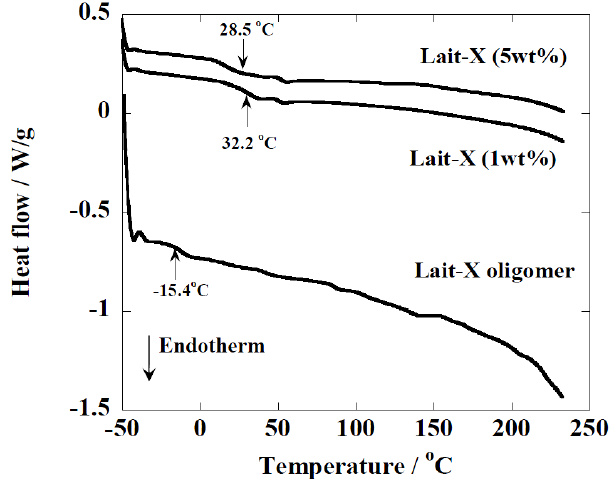
Figure 3. temperature-modulated DSC (TMDSC) scans of Lait-X oligomers and Lait-X bulk with different concentrations of initiator. For cured Lait-X, the content of the initiator is shown.